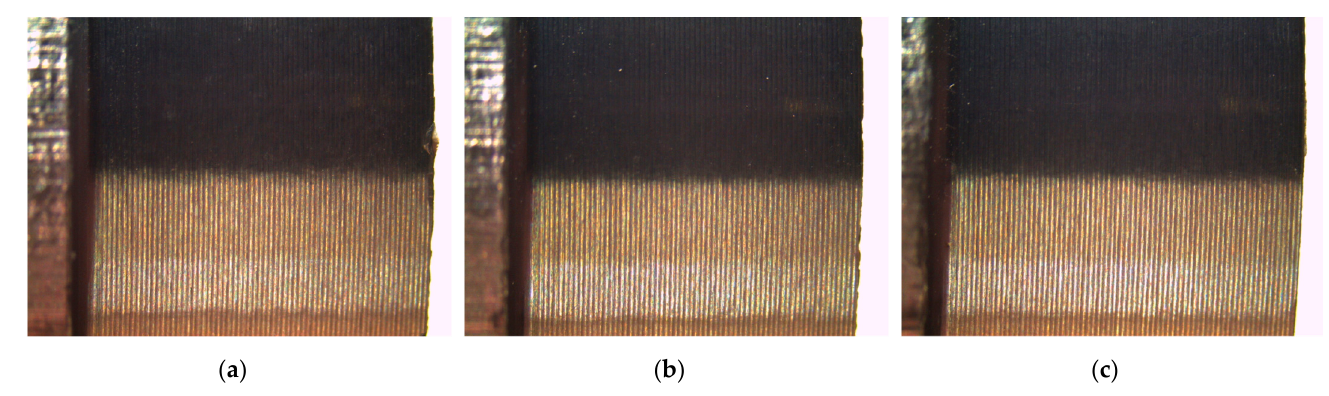
Figure 11. Micrographs taken of some of the machined specimens using the tool CT-s5: ( a ) for the test at 60 m/rev; ( b ) for the test at 80 m/rev; ( c ) for the test at 100 m/rev.